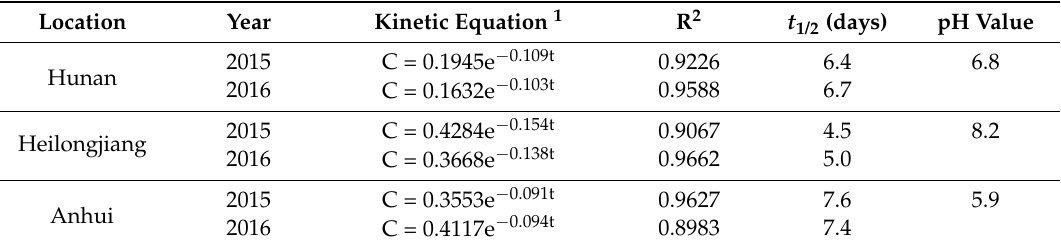
Table 4. Dissipation, t 1/2 and correlation coefficients of oxadiargyl in paddy soil.